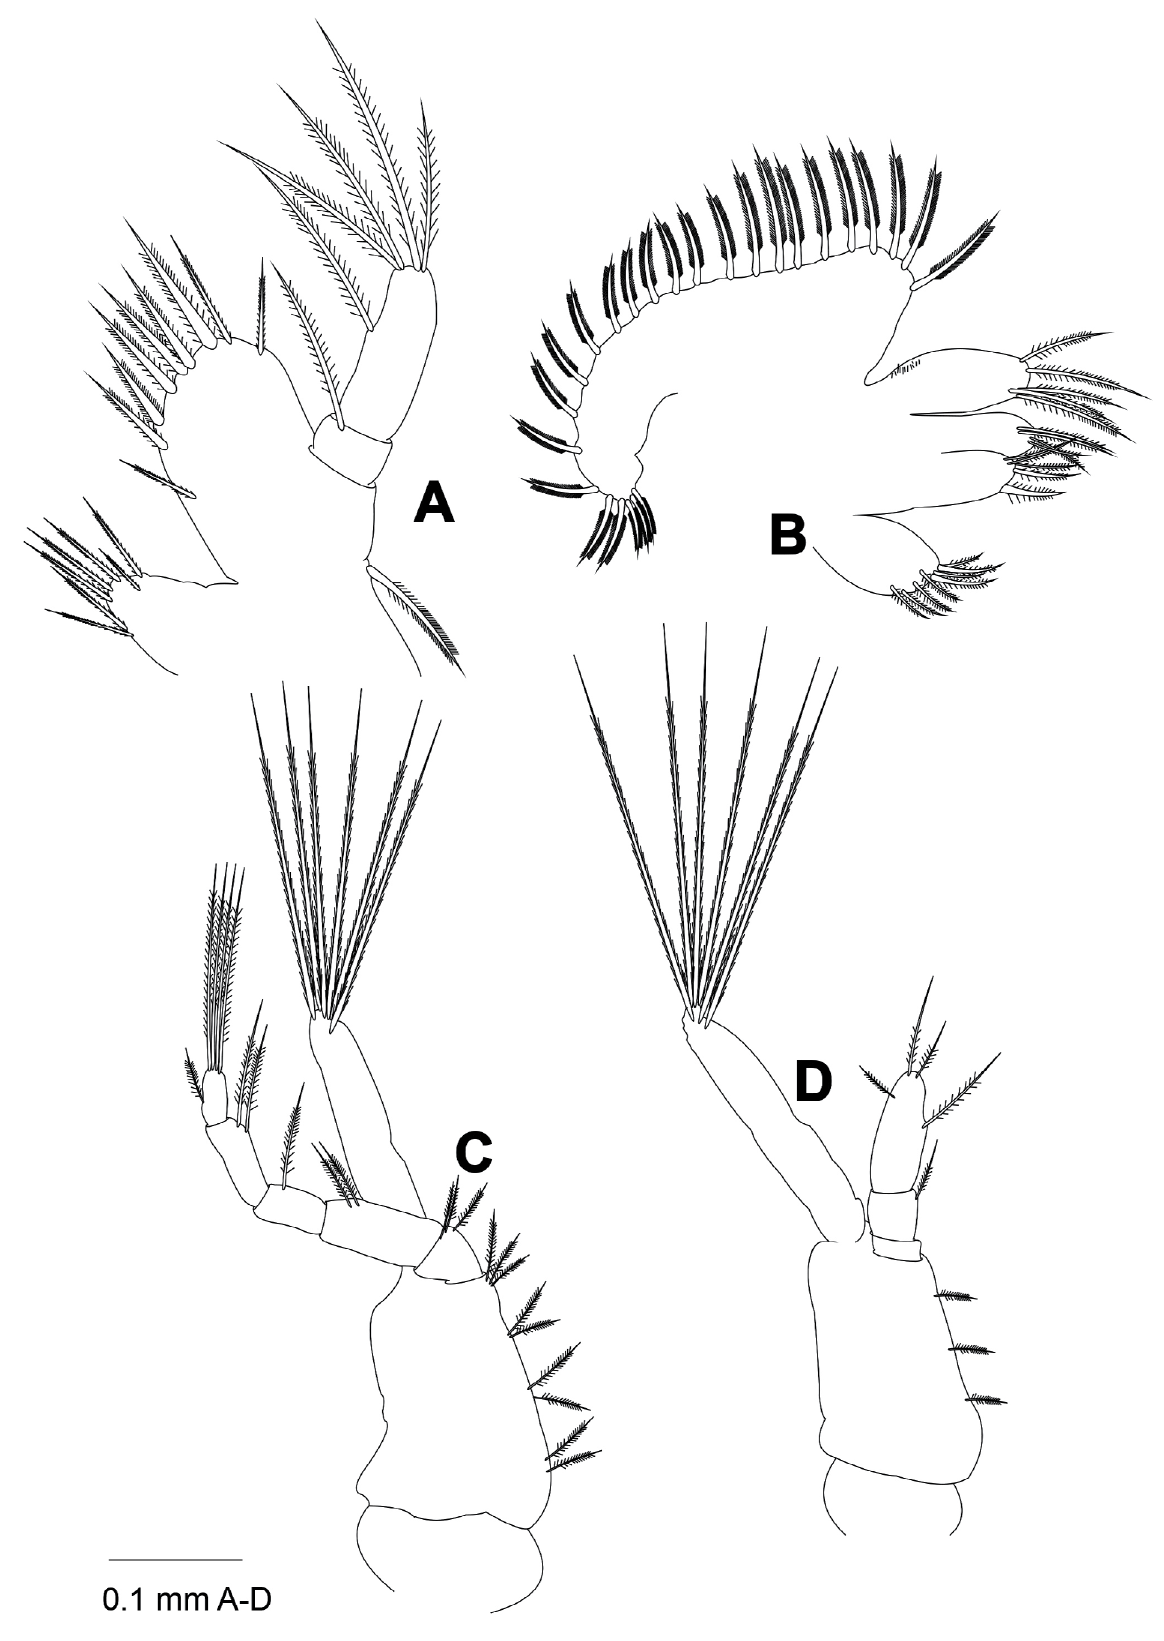
Figure 4. Libinia rhomboidea second zoea. ( A ) Maxillule; ( B ) maxilla; ( C ) first maxilliped; ( D ) second